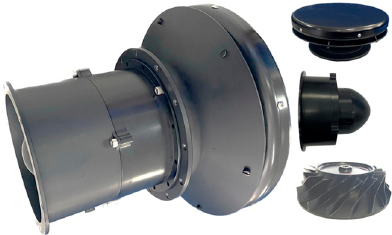
Figure 9. Optimized MIX-130 fan.